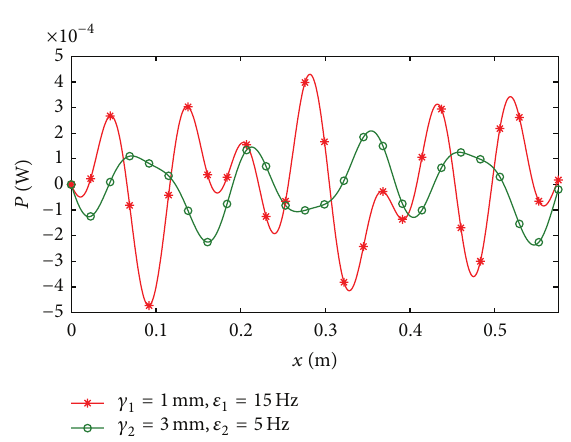
Figure 6: Vibration power flow of the FRMEJ with different disturbance amplitudes and frequencies.